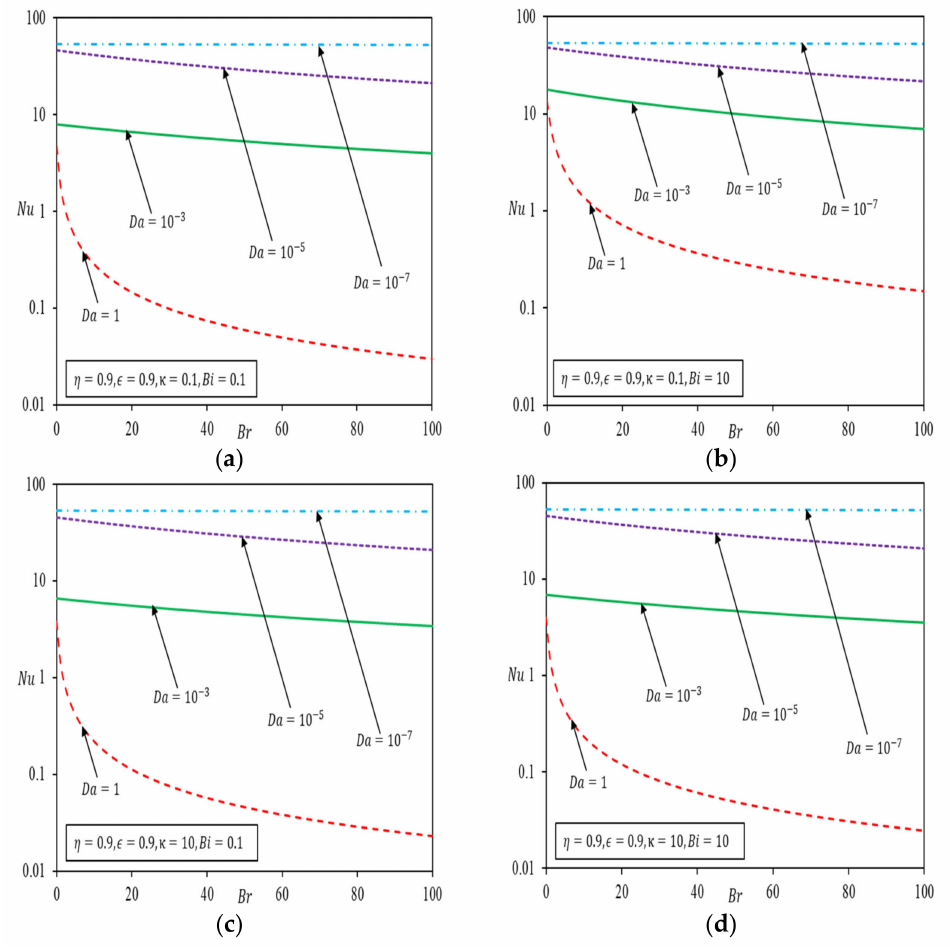
Figure 5. Nusselt number versus Brinkman number with porous medium thickness η = 0.9. ( a ) κ = 0.1, Bi = 0.1 ( b ) κ = 0.1, Bi = 10 ( c ) κ = 10, Bi = 0.1 ( d ) κ = 10, Bi =